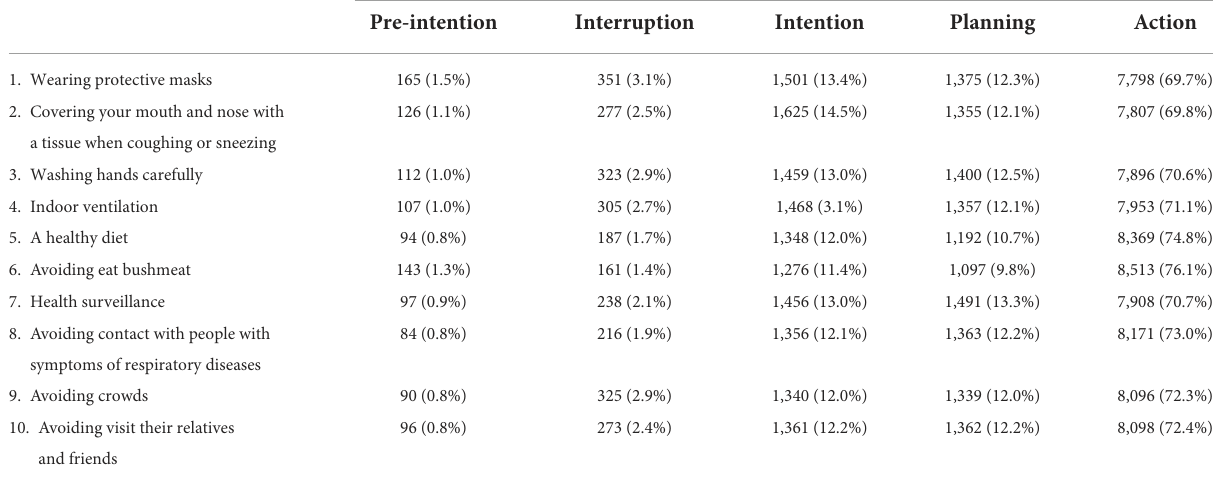
TABLE 1 COVID-19 preventive behaviors by